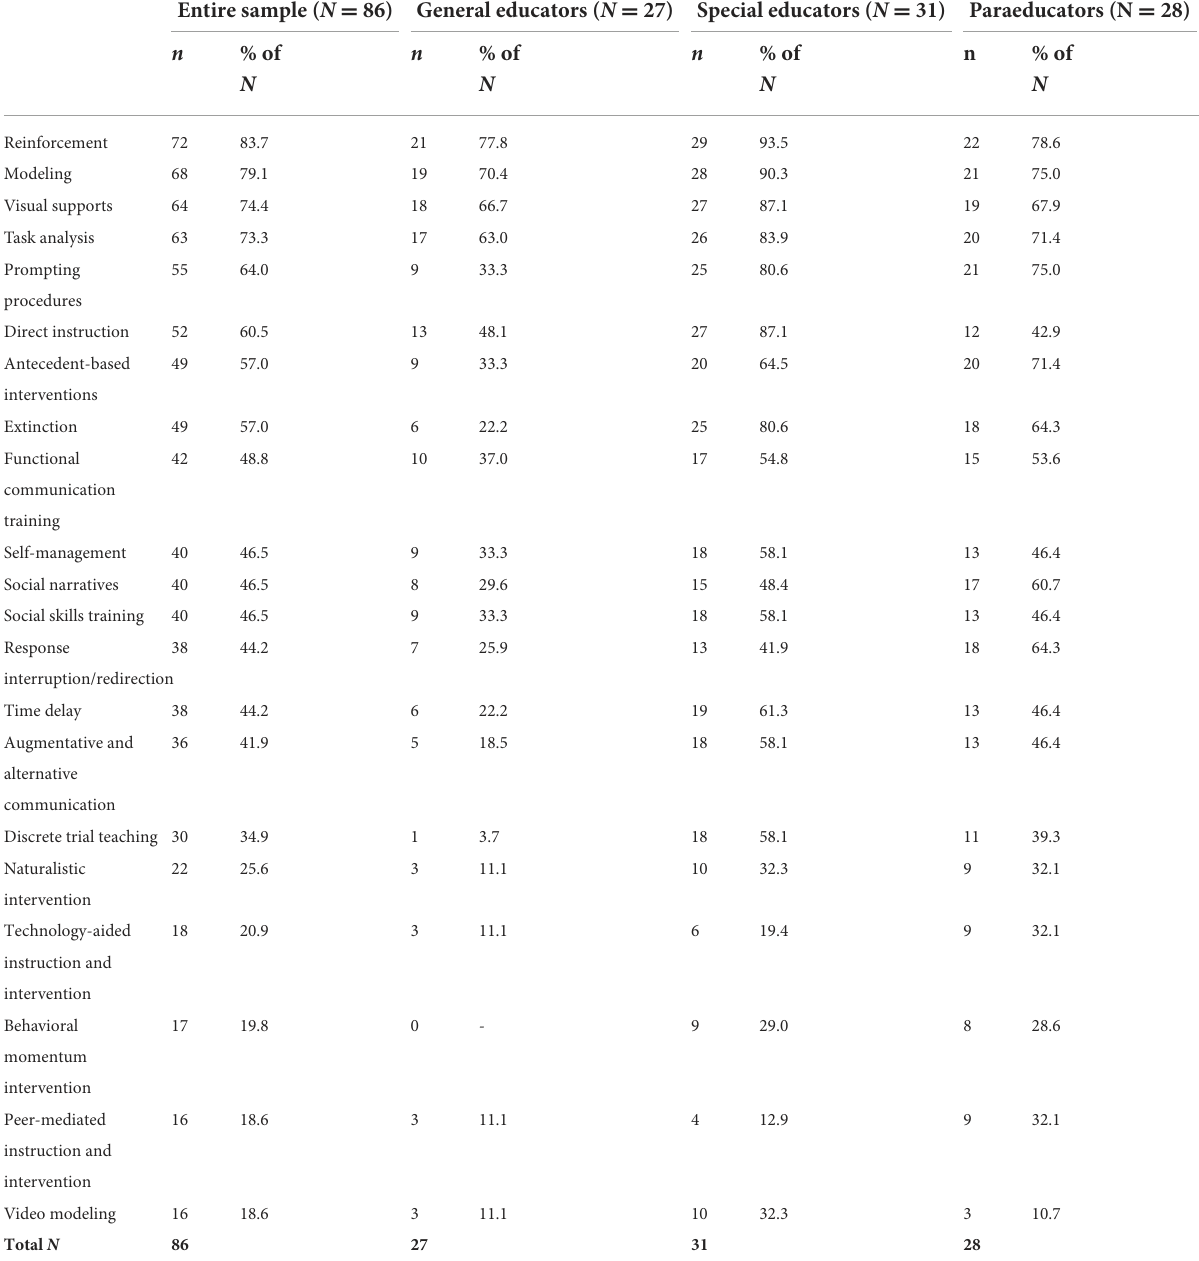
TABLE 3 Multicomponent practice and strategies training (ranked by entire sample). Training in multicomponent practices and